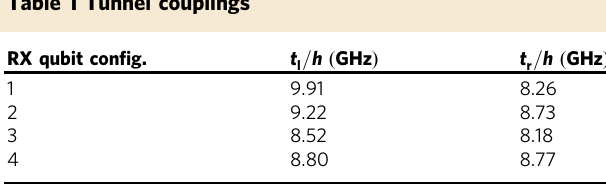
RX qubit con fi g.